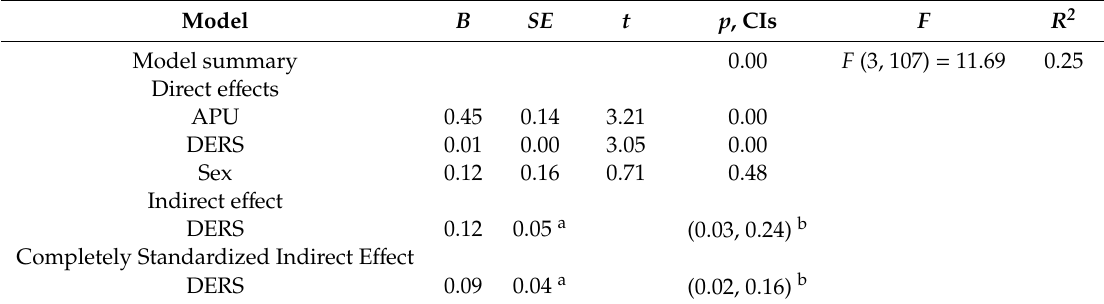
Table 4. Emotion Regulation Di ffi culties (DERS) as a Mediator of the Relation Between Addictive Phone Use (APU) and Restrained